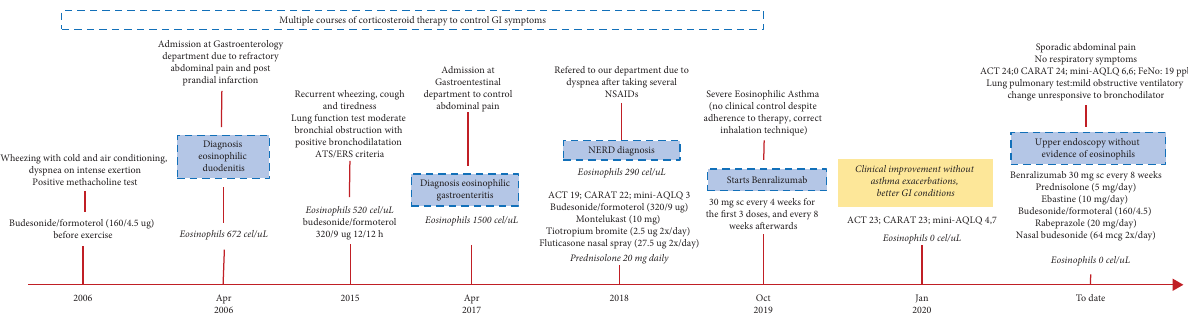
Figure 1: Timeline of the case report: patient journey and main